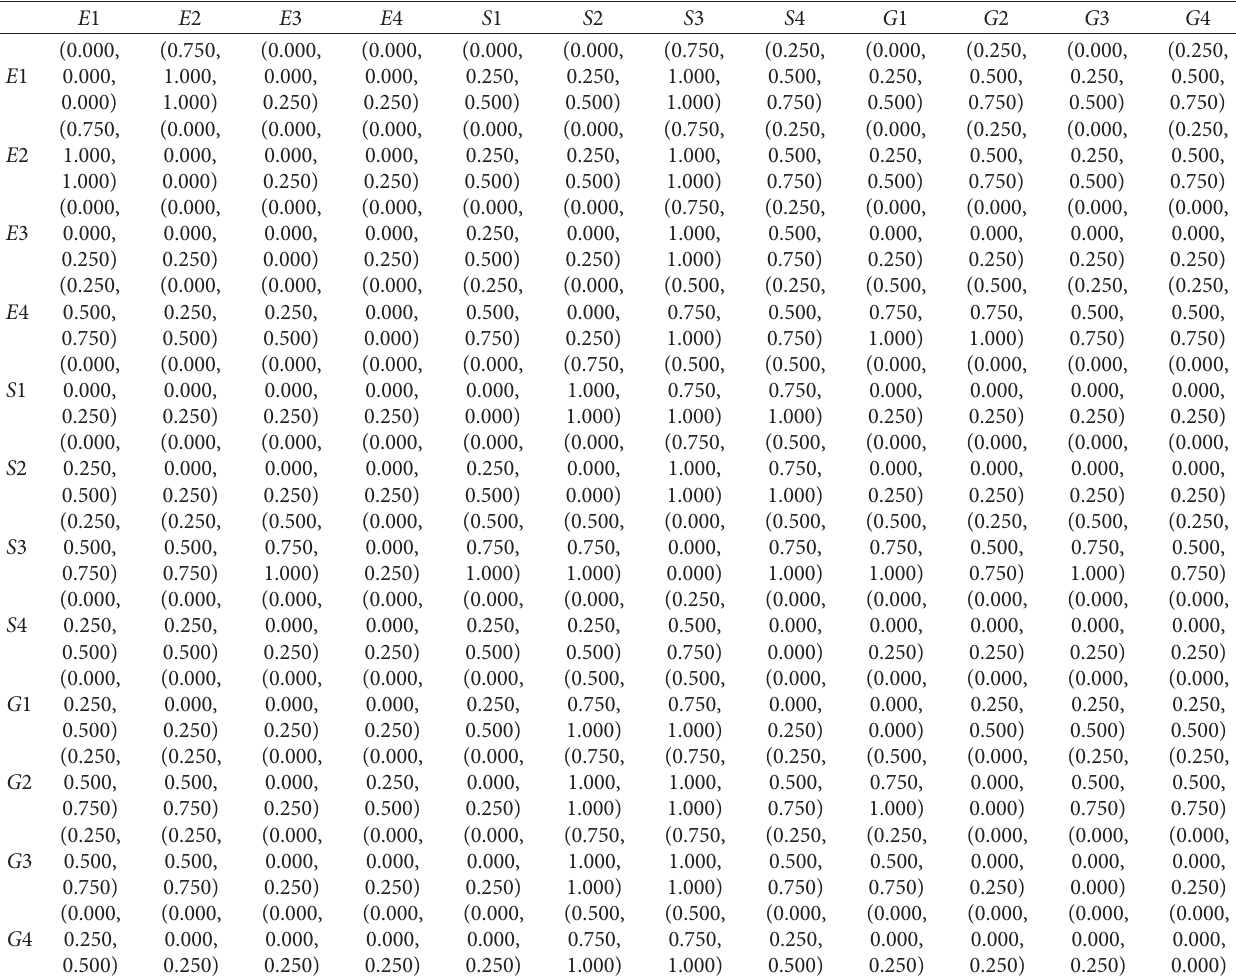
Table 38: Comparison matrix of linguistic variable of sustainability criteria in fuzzy